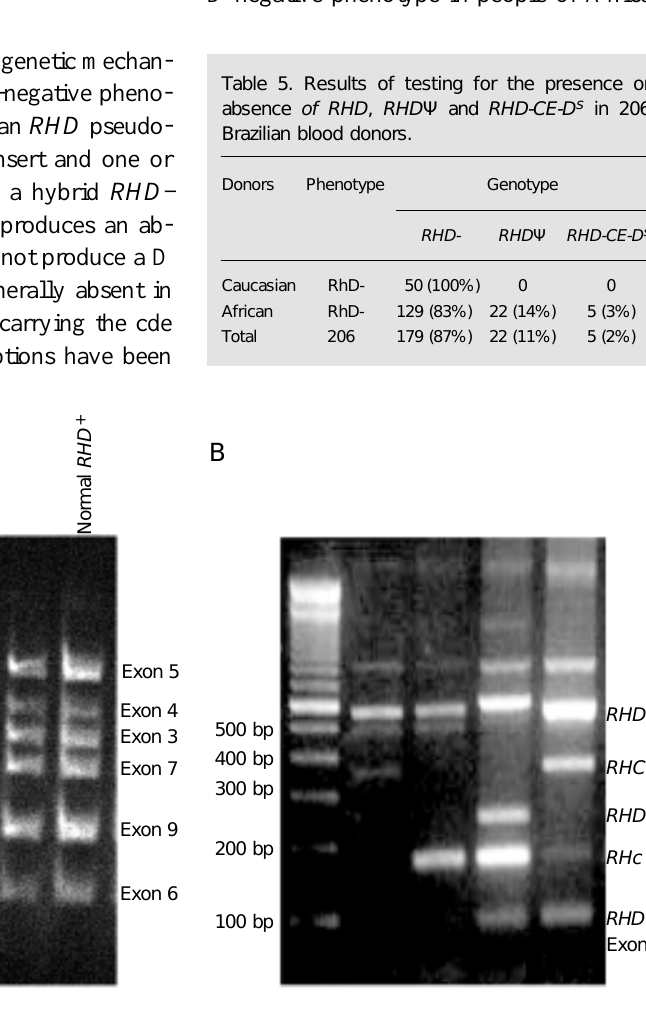
Table 5. Results of testing for the presence or absence of RHD , RHD Ψ and RHD-CE-D s in 206 Brazilian blood